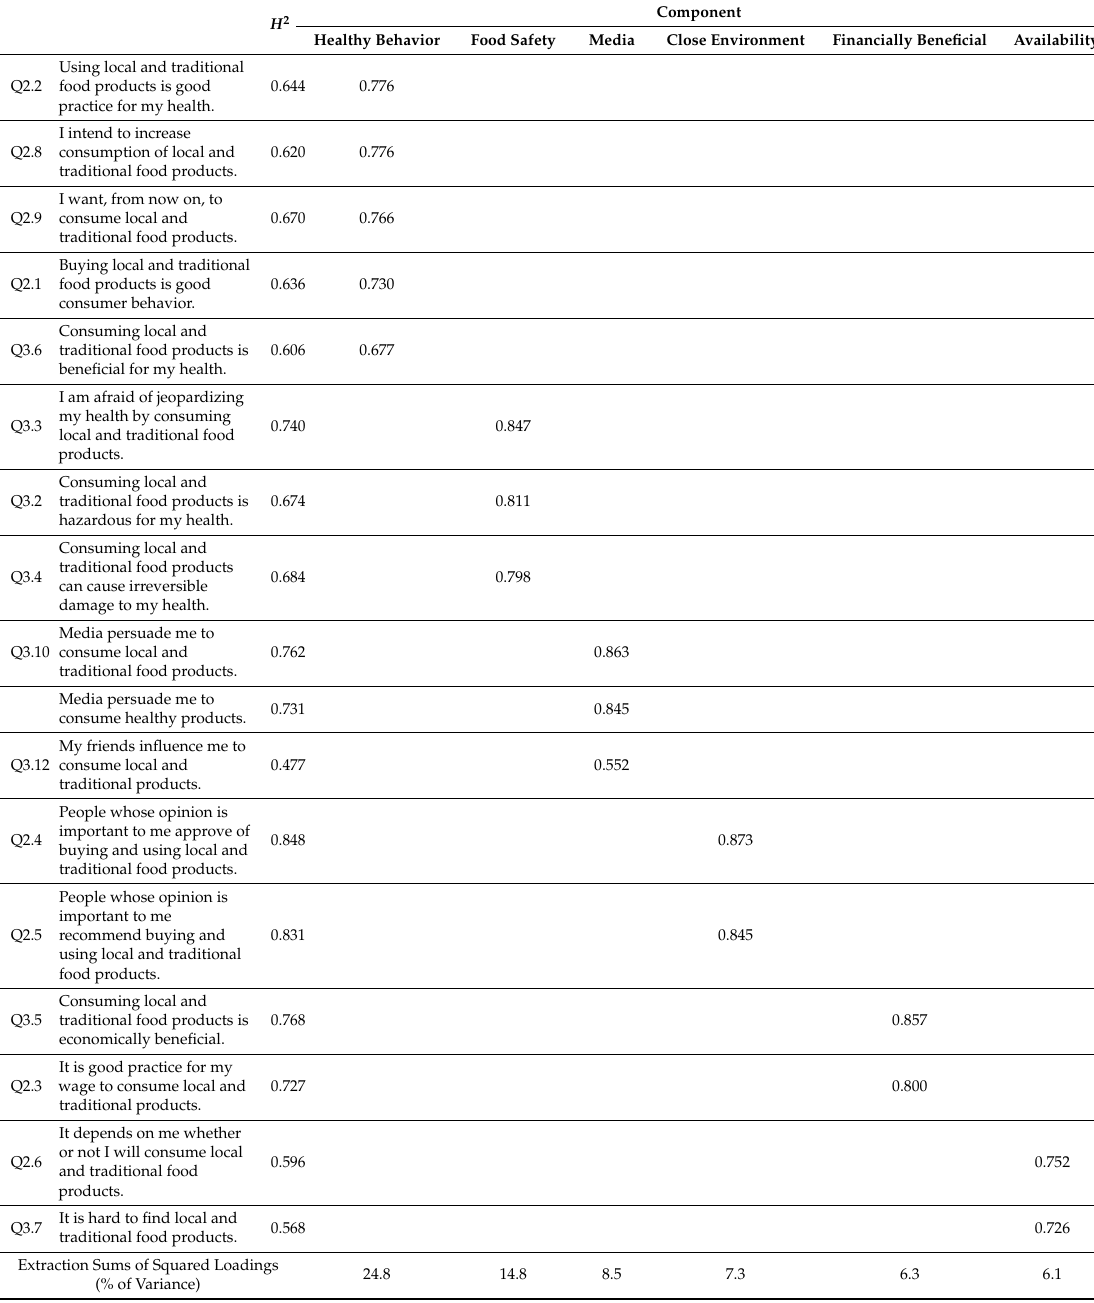
Table 5. PCA results for subset 1 sample ( n =